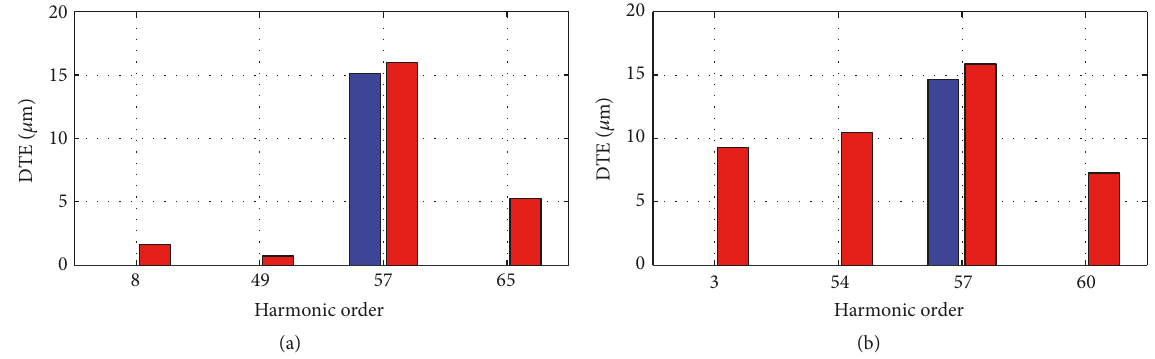
Figure 9: Amplitude of different harmonic orders obtained from FFT of DTE curves obtained for gear pair (a and b) (a) and for gear pair (c and d) (b). The rotational speed is kept in each simulation constant. Blue histograms refer to axisymmetric gears.